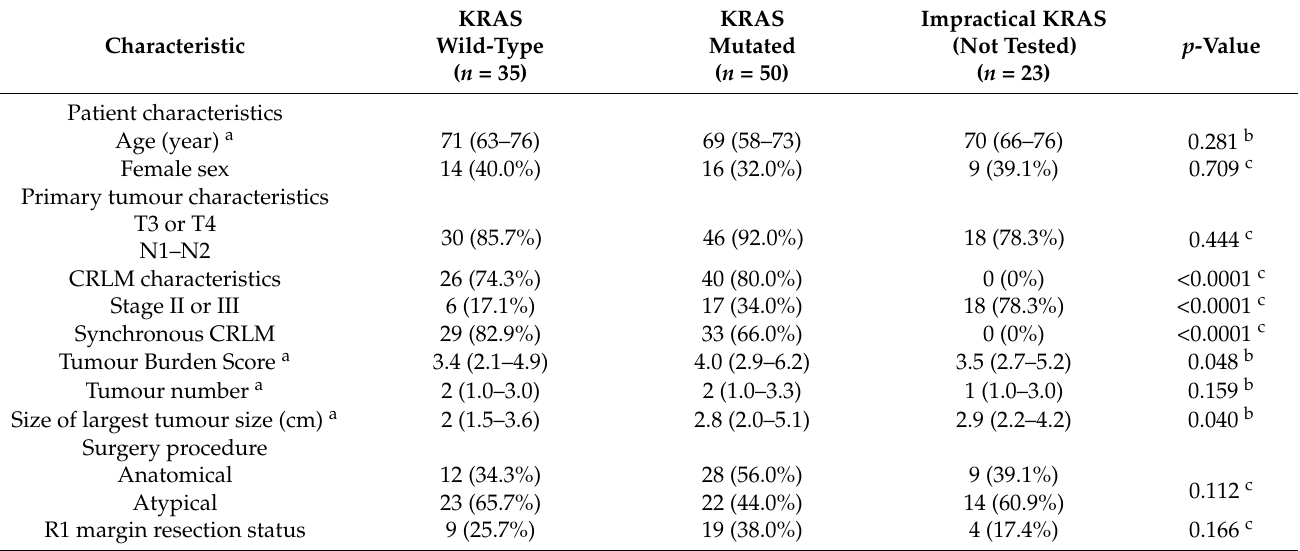
Table 1. Clinical Characteristics and Pathologic Features of KRAS -Mutant, KRAS -Wild-Type and Impractical KRAS in Colorectal Cancer